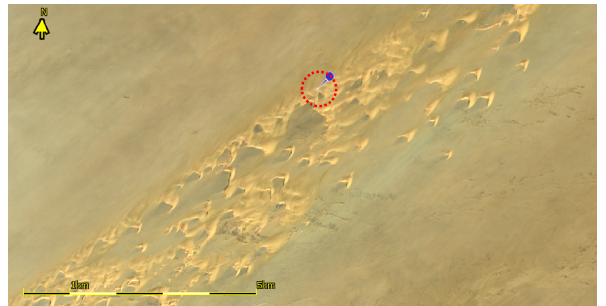
Figure A4. ©Copernicus data (2019). Sentinel-2 natural colour composite showing a sand deposit (barchan dune) dust source, ∼ 35km north- east of Faya-Largeau, Chad. This source emitted dust on 23 December 2015. The location of the pin is latitude 17.4655, longitude 19.6163. A 750m buffer is included in red. Background: European Space Agency Copernicus Sentinel-2 data 2018. Sentinel-2 data are provided under the terms and conditions prescribed by the European Commission’s Copernicus Programme. For detailed information on the data policy, appropriate usage, and citation of Sentinel data, please see: https://scihub.copernicus.eu/twiki/pub/SciHubWebPortal/TermsConditions/TC_ Sentinel_Data_31072014.pdf (last access: July 2018).